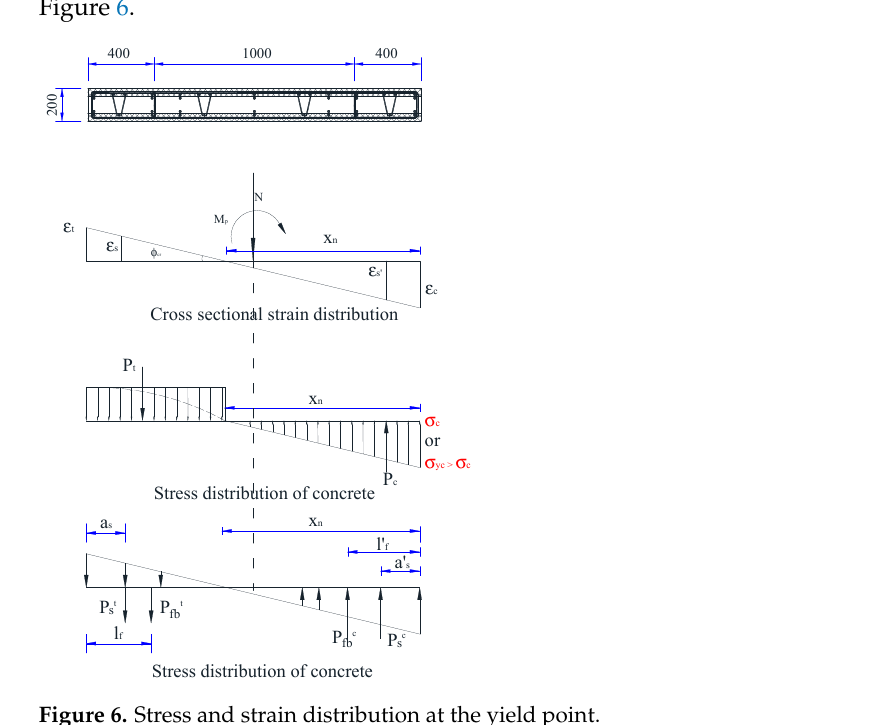
Figure 6. Stress and strain distribution at the yield point.